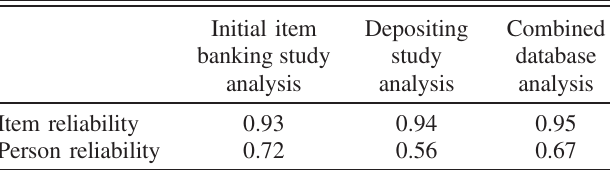
TABLE III. Reliability estimates for the different Rasch analyses.